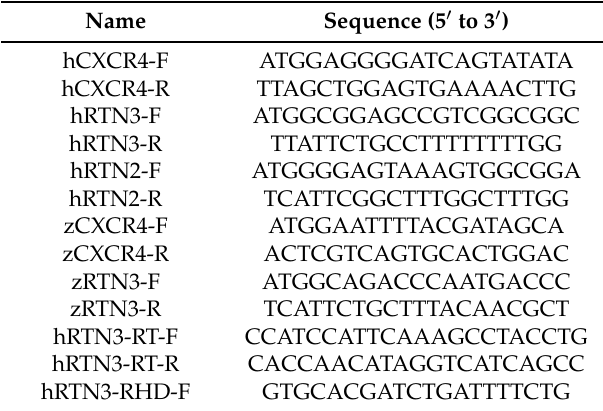
Table 1. Primers used in this